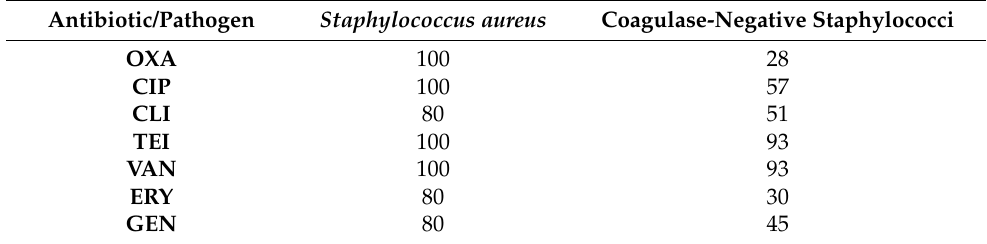
Table 6. Susceptibility of Staphylococcus aureus and coagulase-negative staphylococci to selected antibiotics